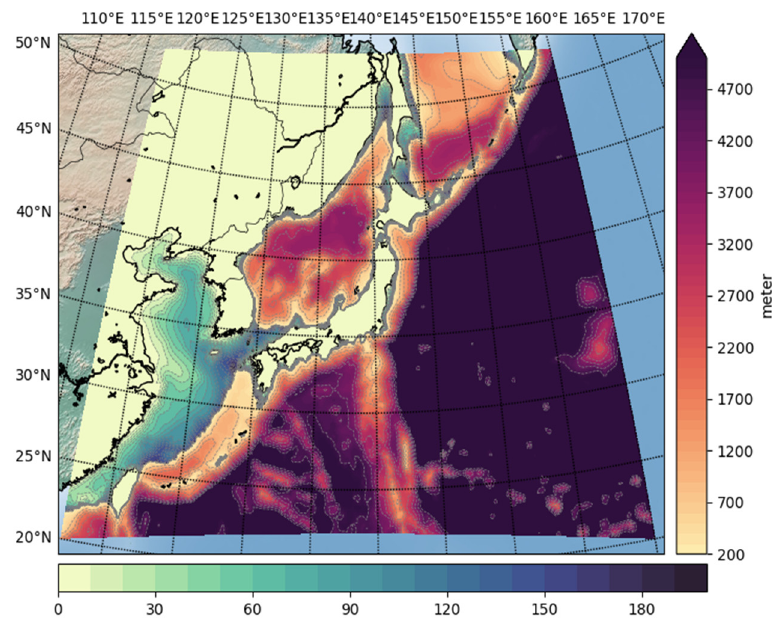
Figure 12. Model area and depth of ROMS for the real experiment. GFS data and HYbrid Coordinate Ocean Model (HYCOM, https: // ncss.hycom.org / thredds /